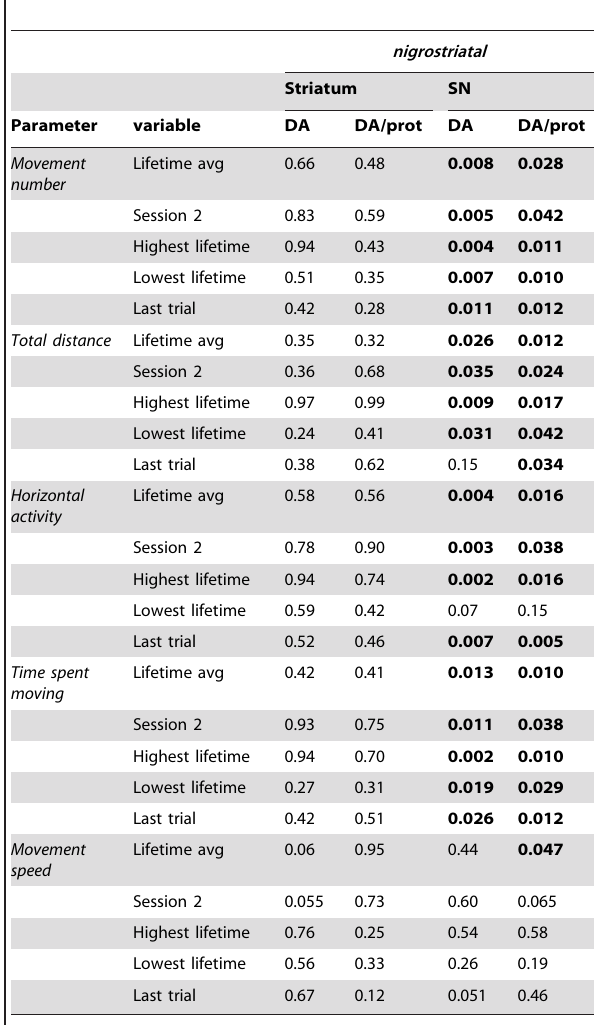
Table 1. p -values of locomotor functions versus DA tissue